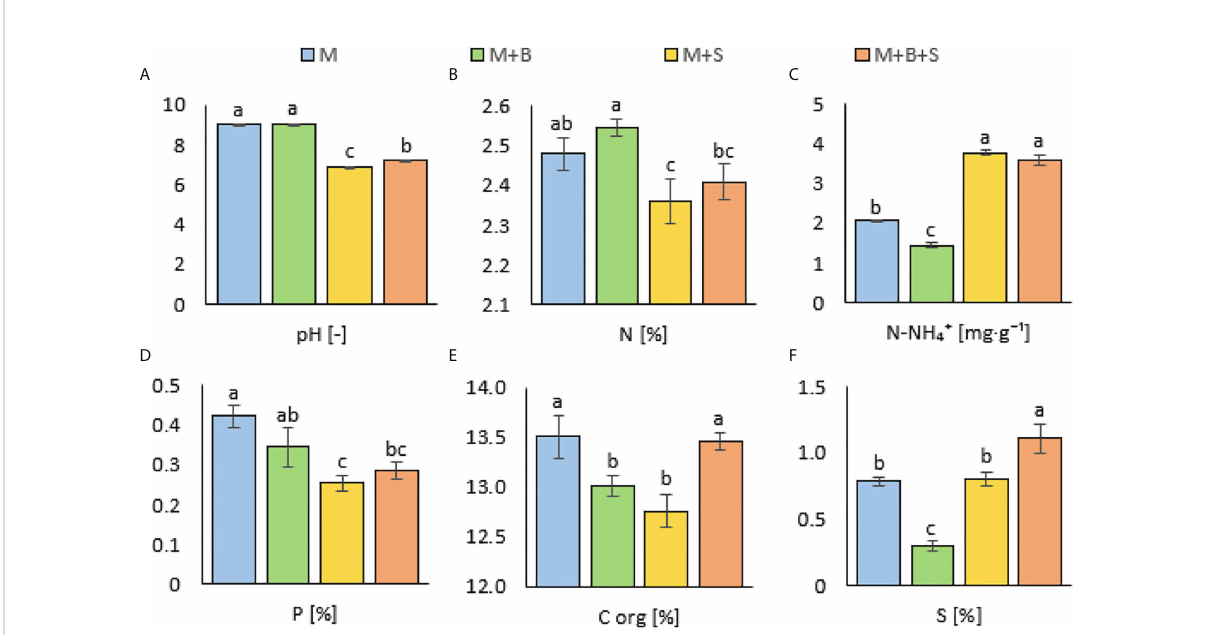
FIGURE 1 Properties of the maturated manures enriched with additives (biochar and S). (A) pH, (B) total Kjeldahl nitrogen, (C) ammonium nitrogen, (D) available phosphorus, (E) organic carbon, (F) total sulphur. Different letters indicate differences at level of signi fi cance p ≤